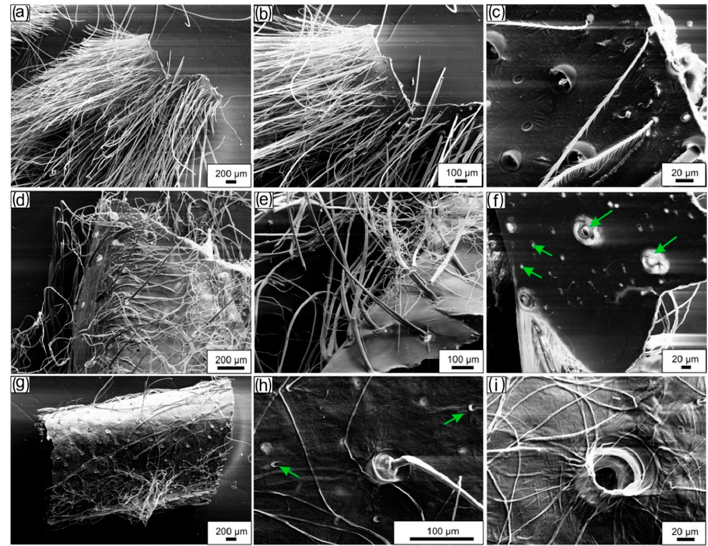
Figure 4. SEM imagery. ( a , b ) A fragment of the naturally occurring molt cuticle obtained from the walking leg of C. versicolor spider represents a brush-like tube. ( c ) The specific structure of individual setae as well as pores on the surface of the molt are well visible on the image. ( d , e ) Lipid-, wax-, and pigment-free cuticle resembles the size, shape, and morphology of the molt. ( f ) Pores (arrows) are well visible also on the inner surface of the tube-like construct. Microwave-assisted treatment of the molt as represented in ( a ) leads to partial removal of the setae ( g ). ( h , i ) Pores of diverse diameter (arrows) remain